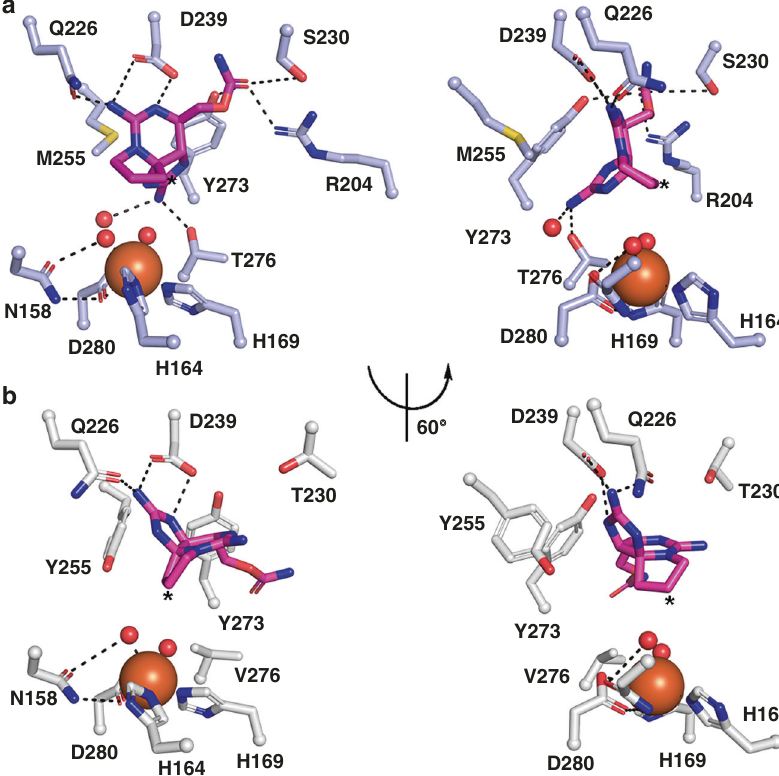
Fig. 4 Structures of SxtT and GxtA with ddSTX bound reveal the protein interactions that are important for correctly positioning substrate for activation. a ddSTX (dark pink sticks) is anchored in the active site of SxtT via interaction with several different residues that are highlighted here. A rotated view of the active site reveals that C12 (asterisk) is the closest position of ddSTX to the non-heme iron site. b The positioning of ddSTX in the GxtA active site places C11 (asterisk) closest to the iron center. Relative to the placement of ddSTX in SxtT, the guanidinium group that interacts with Thr276 rotates nearly 120º to istead interact with Gln226 and Asp239 in the GxtA active site. Both of these residues are conserved in